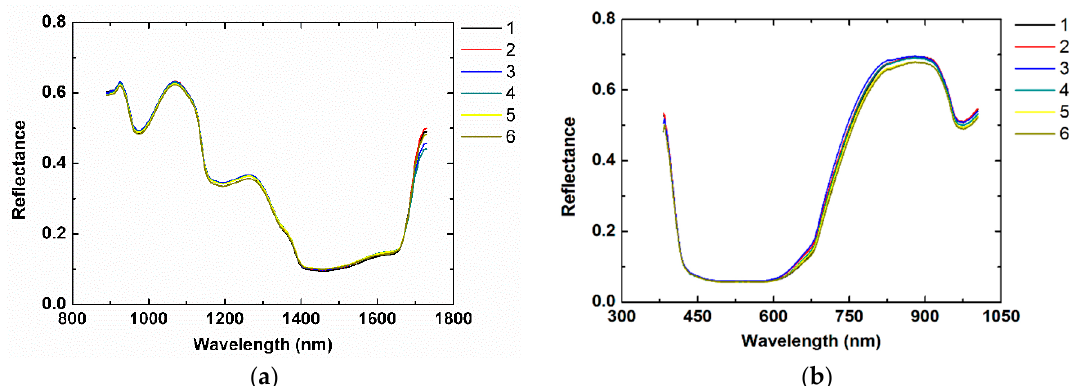
Figure 2. Typical Vis-NIR (visible and near infrared reflectance) hyperspectral profiles measured based on ( a ) system I and ( b ) system II for uncontaminated mulberry samples and samples contaminated with fungicide residue (concentrations of the fungicide solutions used in the samples from groups 1 to 6 were 0 g mL − 1 , 0.0050 g mL − 1 , 0.0025 g mL − 1 , 0.0017 g mL − 1 , 0.0013 g mL − 1 , and 0.0001 g mL − 1 ).